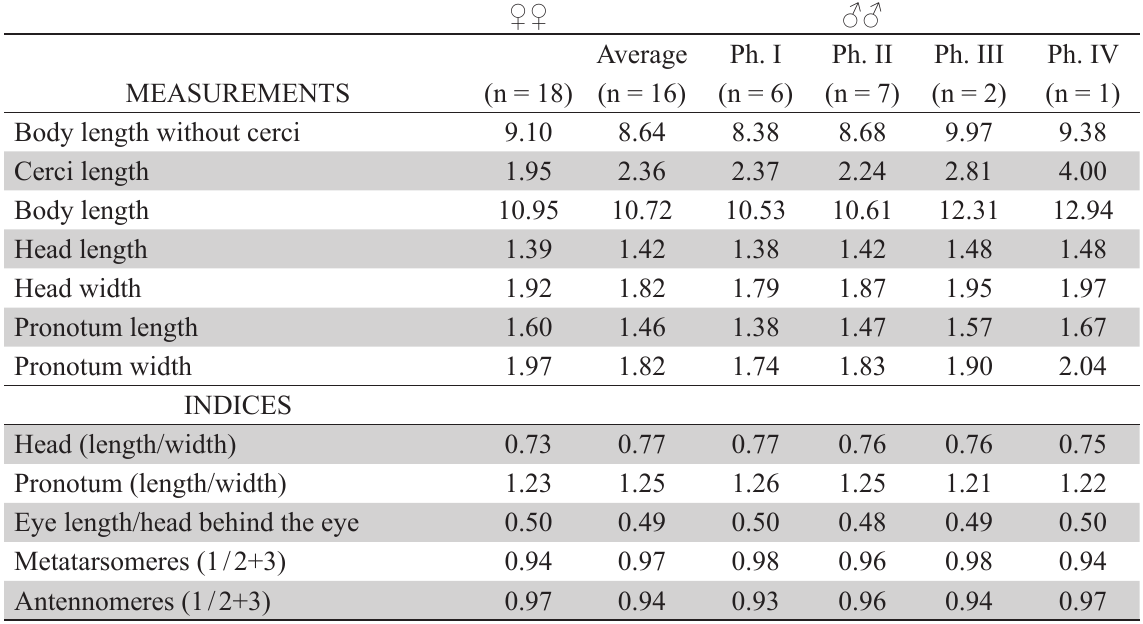
Table 3. Measurements and indices of female and male (including the four different phenotypes of males, Ph. = phenotype) specimens of Pseudochelidura cantabrica Cuesta-Segura, Jurado-Angulo & García-París sp. nov. Phenotype IV corresponds to the